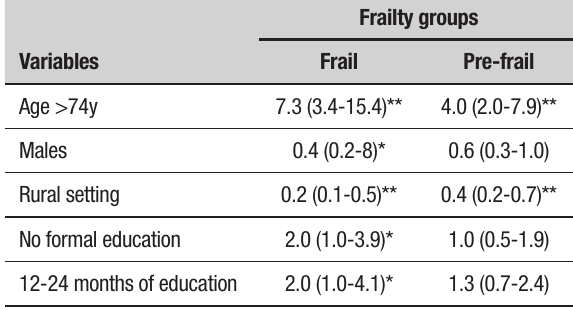
Table 4. Factors (age, sex, setting and level of formal education) as- sociated with being categorized as frail and pre-frail. Odds ratio, 95% confidence intervals in brackets.